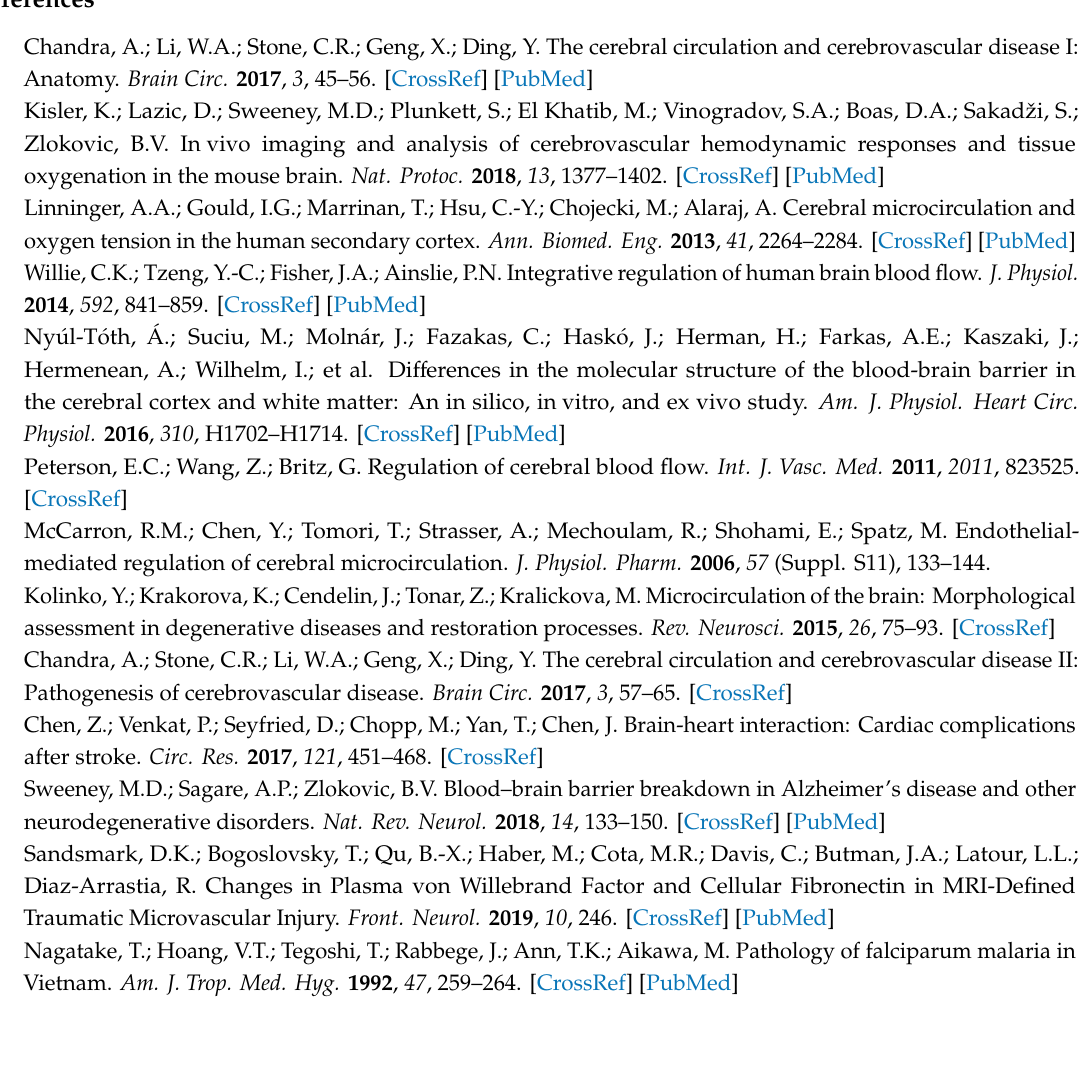
Figure S1: The areas of the brain that were selected for the study, Figure S2: Illustration of Quantification of percentage area of expression of the